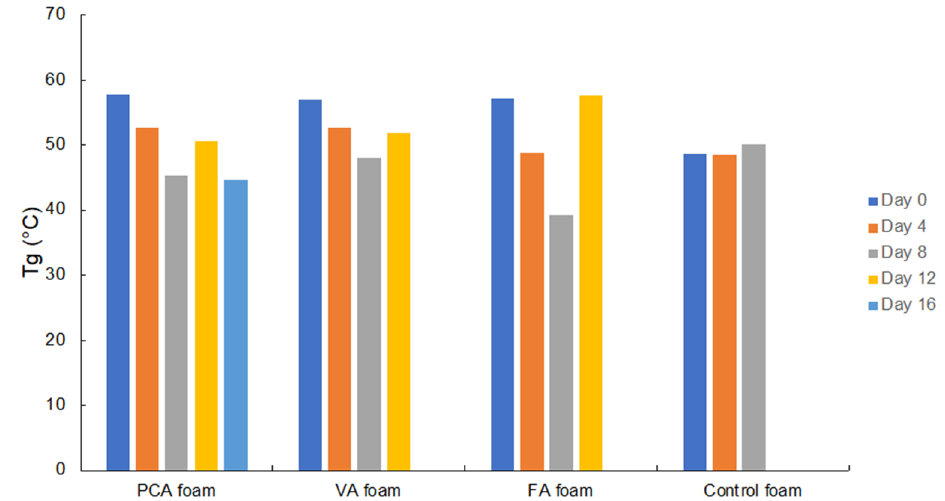
Figure 3. Thermal characterization of glass transition temperature (Tg) of SMP foams over 16 days of degradation in 20% H 2 O 2 . Tg’s were determined using differential scanning calorimetry (DSC). In terms of degradation, T g provides an indication of scaffold crosslink density over time (i.e., T g is reduced as crosslink density decreases), which correlates with bulk degra- dation of the polymer network. The T g of all tested PU SMP foams was fairly stable throughout degradation, which indicates that oxidation occurred primarily on the surface of the foams [66]. The T g of the control foam remained almost unchanged during oxidative degradation. The T g of PA foams generally decreased or remained the same during deg- radation. The higher initial (Day 0) T g of the PA foams in comparison with the control (~57 ◦ C vs. ~48 ◦ C for control) is attributed to the phenolic rings that increase the foam backbone stiffness. Therefore, as the PAs were gradually released during degradation, the